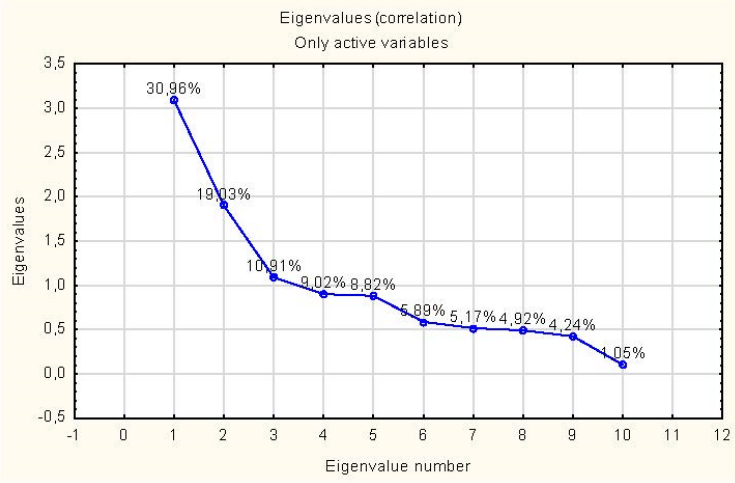
Figure 1. Scree plot.